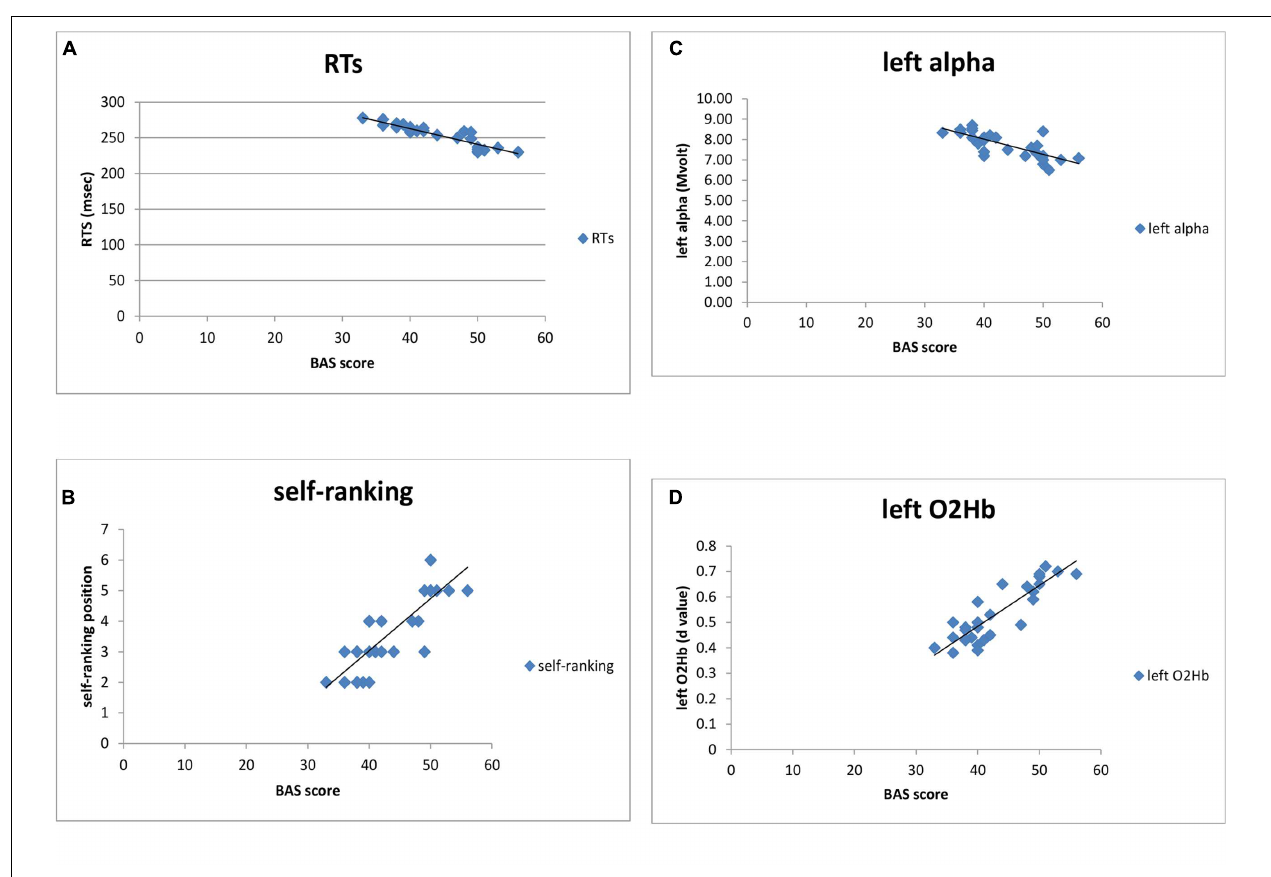
FIGURE 8 | Stepwise regression analyses, between (A) BAS and RTs, (B) BAS and self-ranking, (C) BAS and alpha band, (D) BAS and left